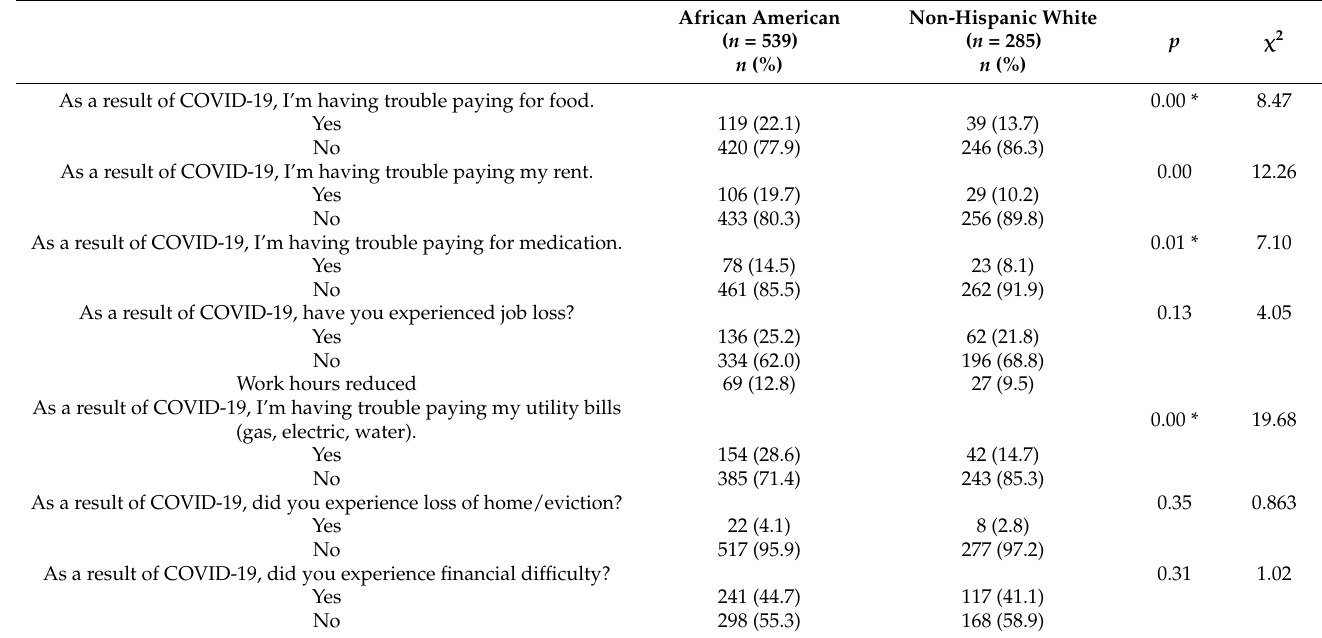
Table 4. COVID-19 Financial Difficulty Variables by Race/Ethnicity ( N =